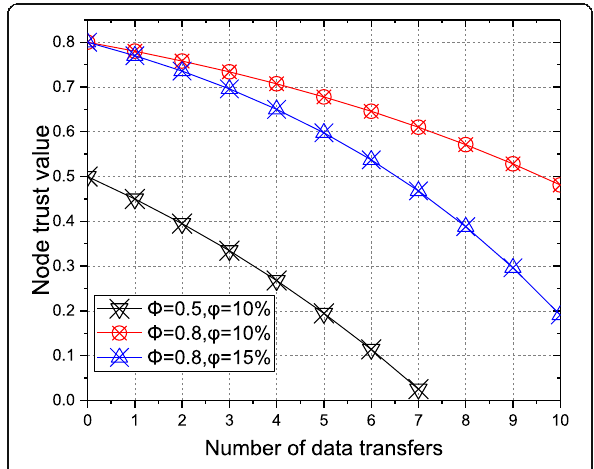
Fig. 6 Change of trust value if verification is successful